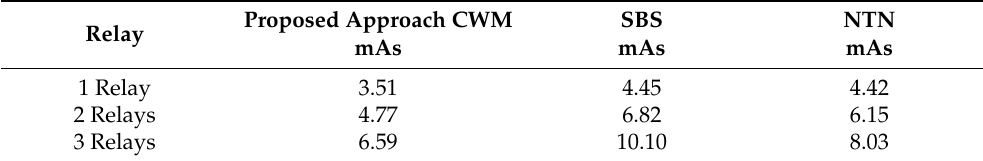
Figure 17. Nodes of energy consumption related to the number of relay nodes comparing the 3 strategies.